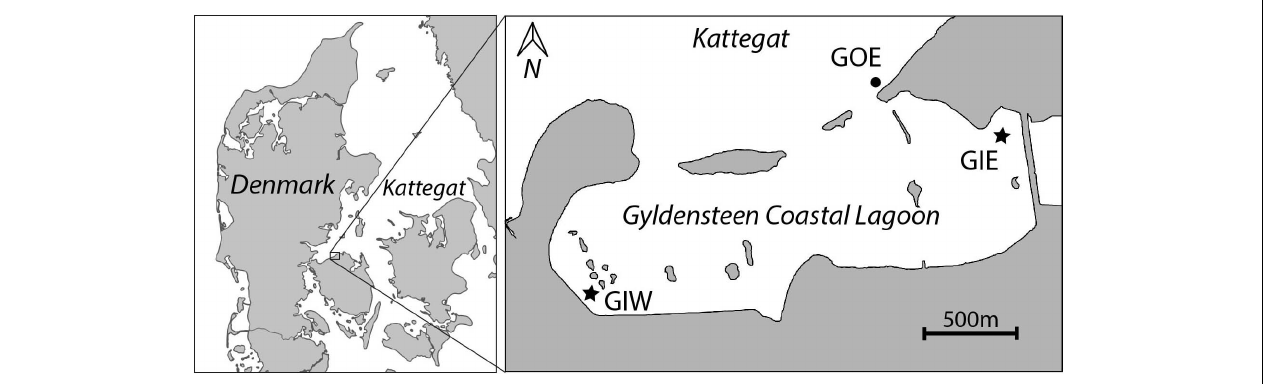
FIGURE 1 | Map of Gyldensteen Coastal Lagoon in Denmark (inserted map) with location of monitoring and sampling stations GIE, GIW, and GOE